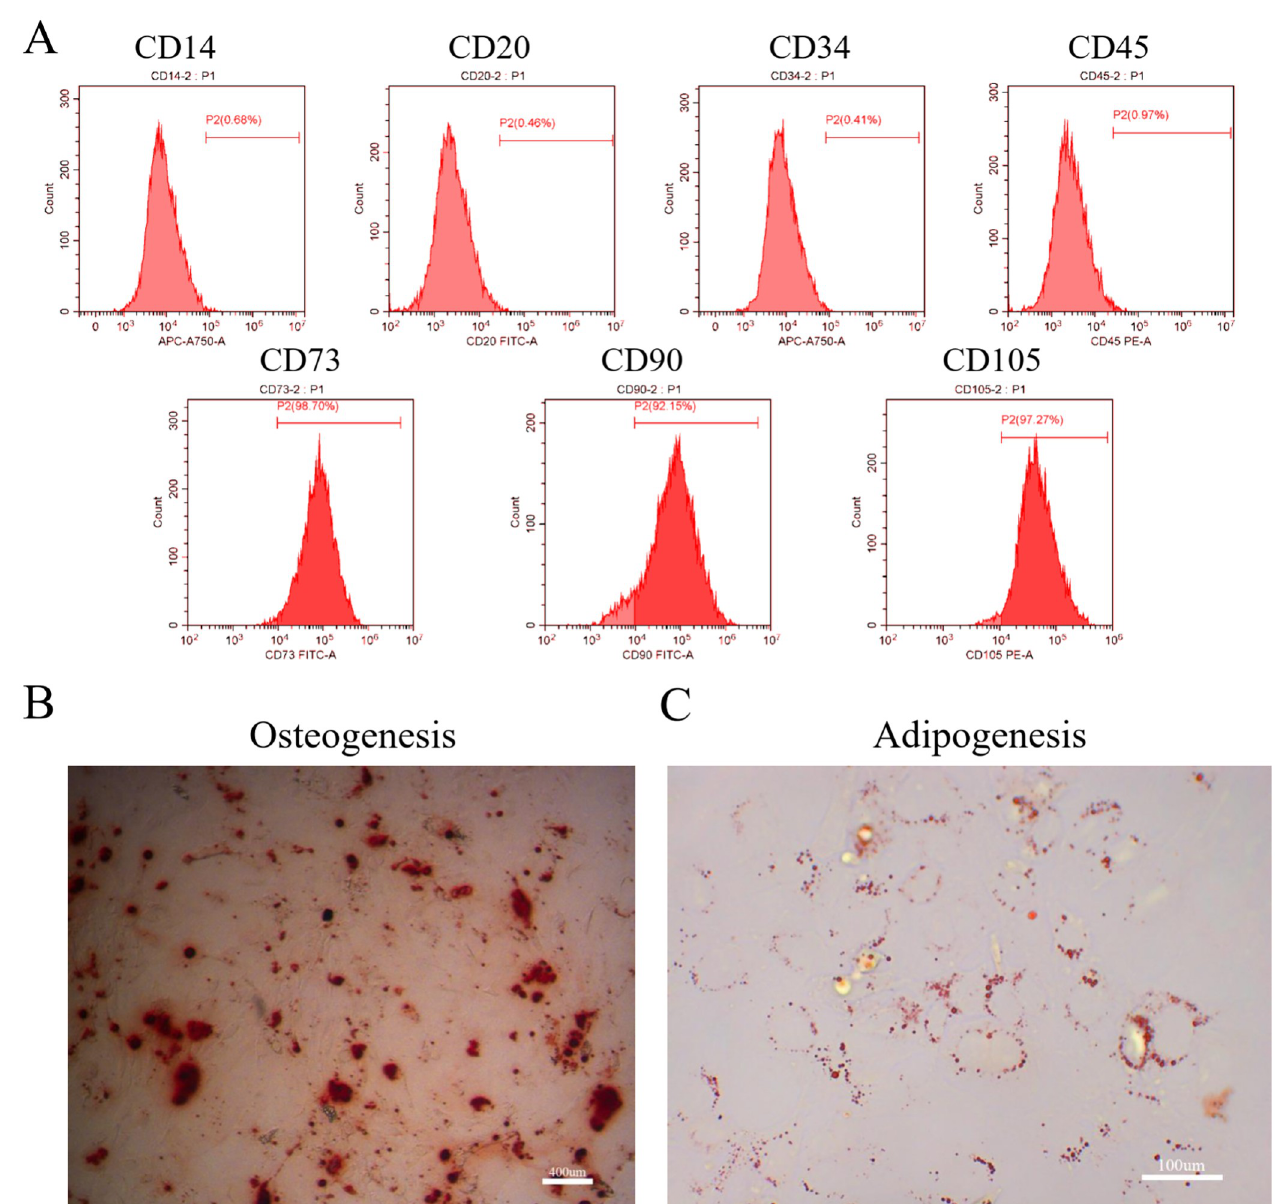
Fig 2. Identification of dental pulp stem cells (DPSCs). Flow-cytometry (A) illustrates the immunophenotypic characteristics of human DPSCs. Human DPSCs were positive for cell surface antigens CD73, CD90, and CD105, as well as negative for CD14, CD20, CD34, and CD45. DPSCs were cultured under osteogenic (B, 14 days) or adipogenic (C, 21 days) conditions and showed mineralized nodules and lipid clusters as revealed by alizarin red and oil red staining, respectively. Scale bar = 400 (B) or 100 (C) μ m.